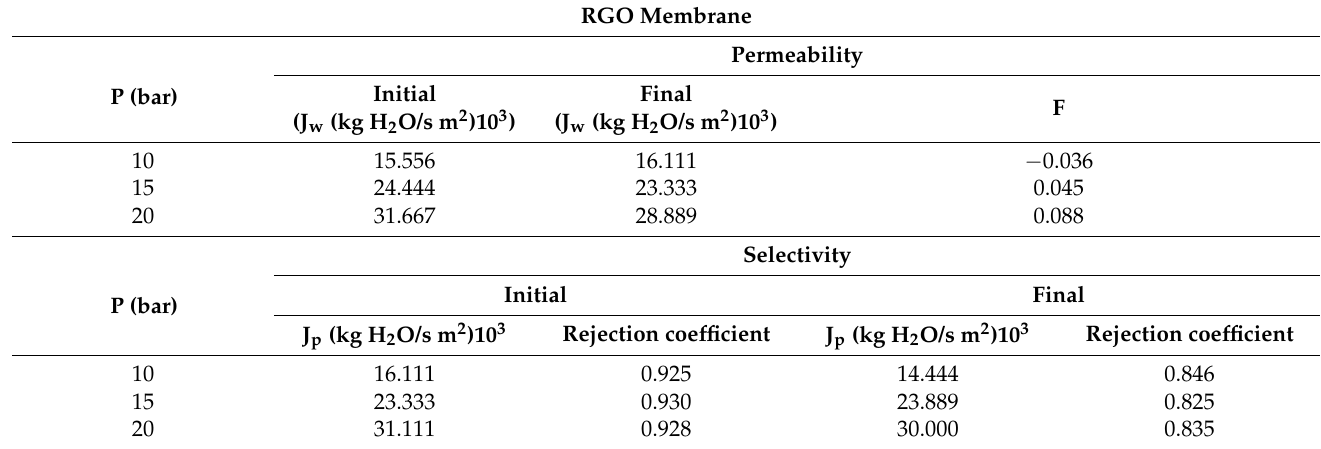
Table 5. Initial and final permeate mass flows from the permeability and selectivity tests, rejection results of the saline solutions, and fouling factor of the membrane modified with reduced graphene oxide.